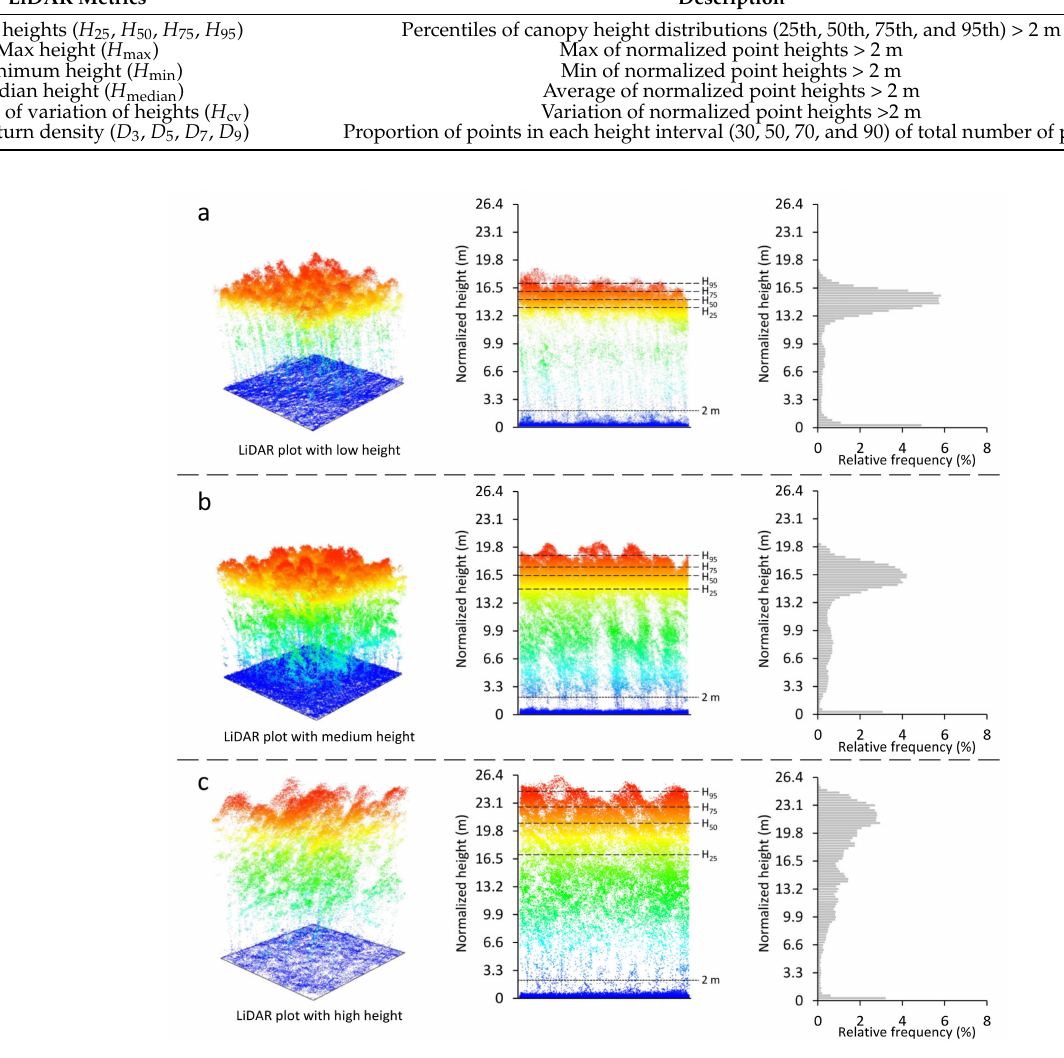
Figure 2. The UAV-LiDAR plots, vertical profiles of point clouds, and canopy height distributions of each plot with low ( a ), medium ( b ), and high heights ( c ). The 2 m threshold and LiDAR metrics H 25 , H 50 , H 75 , and H 95 are presented with the dotted